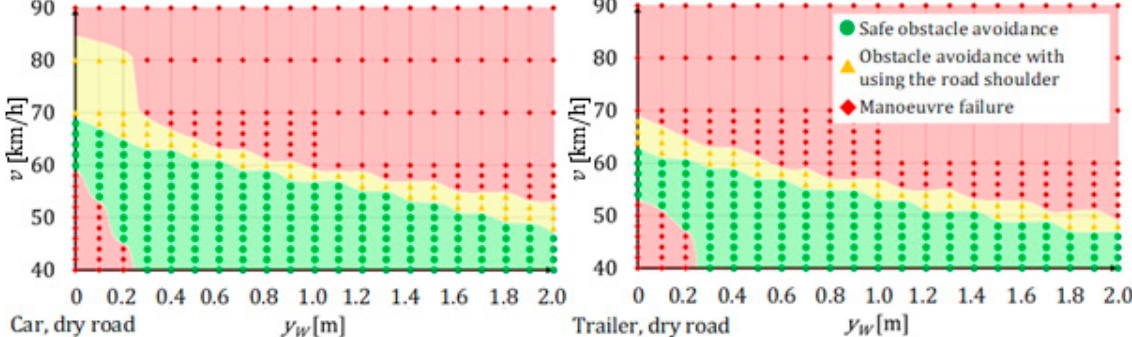
Figure 22. Area of choosing the y W values when planning a vehicle trajectory for safe obstacle avoidance on dry road surface; motorcar and trailer.